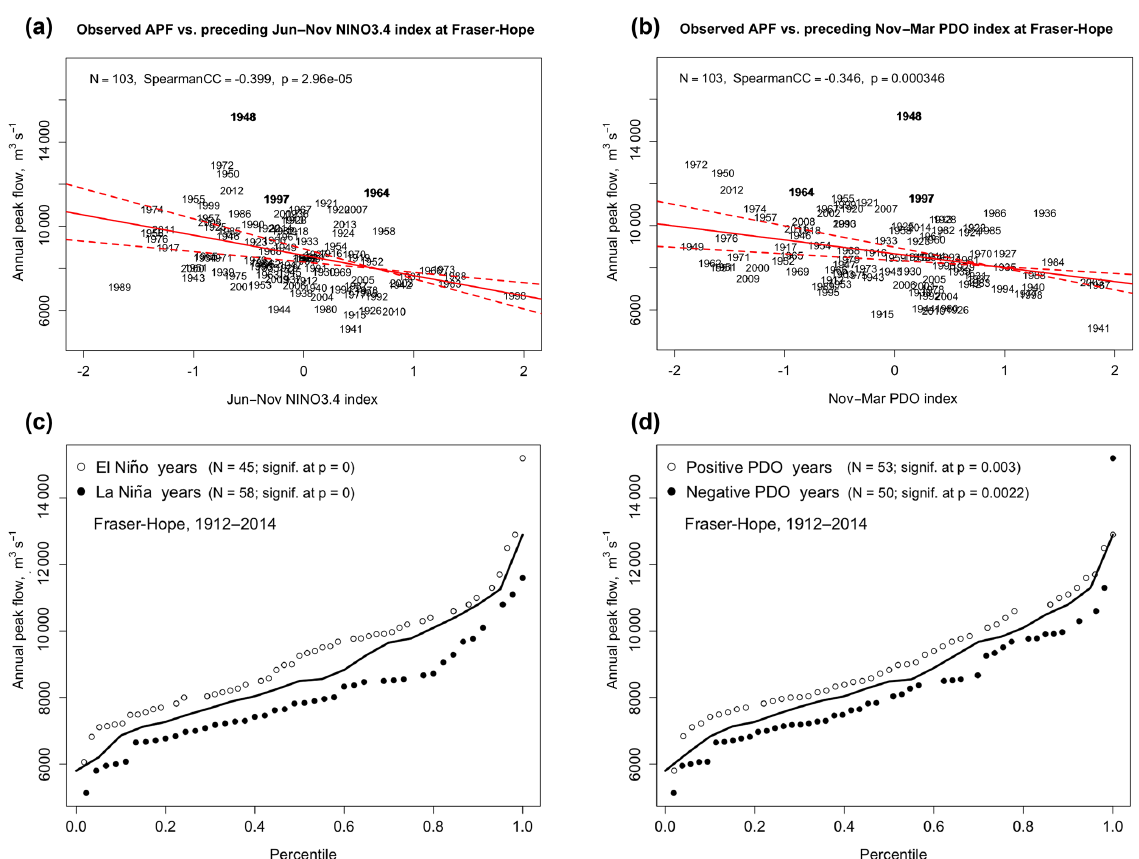
Figure 2. (a) Regression of observed annual peak daily streamflow (APF) magnitude at Fraser-Hope hydrometric station (vertical axis) against the NINO3.4 index over the period 1912–2014. Year labels are plotted as individual points. (b) Same as in (a) but for the PDO index. Years in boldface font are discussed in the text of Sect. 3.2. (c) Percentiles of APF in years when the NINO3.4 index is in the negative (La Niña) phase (filled circles) versus the positive (El Niño) phase (open circles). The solid curve shows the median result of resampling the combined data set of both ENSO phases 10 4 times. The significance of differences between APFs in either phase and corresponding samples of the combined data set is assessed using a permutation test (Sect. 2.3), resulting in the indicated p -values. (d) Same as in (c) but for the PDO